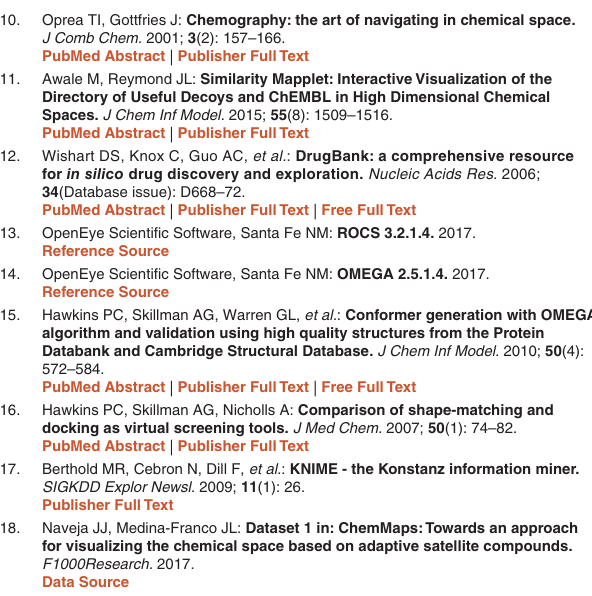
Supplementary File 1: File with supporting methods, results and five figures. Figure S1: 3D-Consensus Diversity Plot depicting the diversity of the datasets used for the backwards approach; Figure S2: Backwards analysis with 3PCs picking satellites by diversity; Figure S3: Backwards analysis with 3PCs picking satellites at random; Figure S4: Forward analysis with 2PCs picking satellites at random with step sizes of 10%; Figure S5: Plot of the percentage of variance explained by each principal component in the studied datasets. Click here to access the